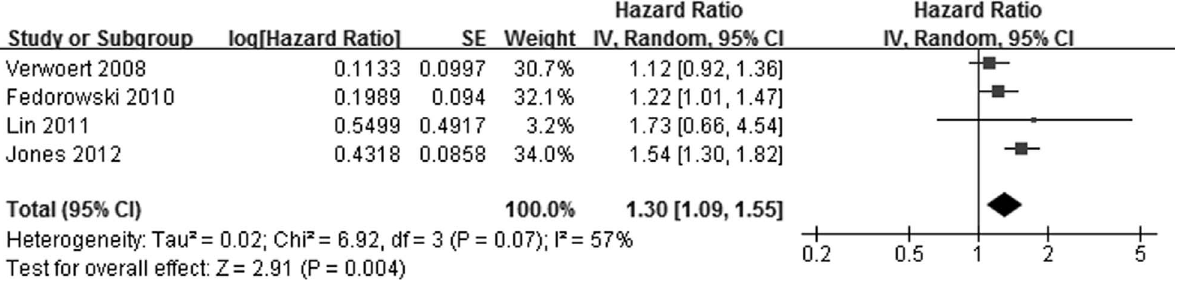
Figure 2. Adjusted hazard ratio of congestive heart failure in subjects with orthostatic hypotension at baseline compared those without orthostatic hypotension. CI, denotes confidence interval; the size of each square is proportional to the study’s weight (inverse of variance – IV).